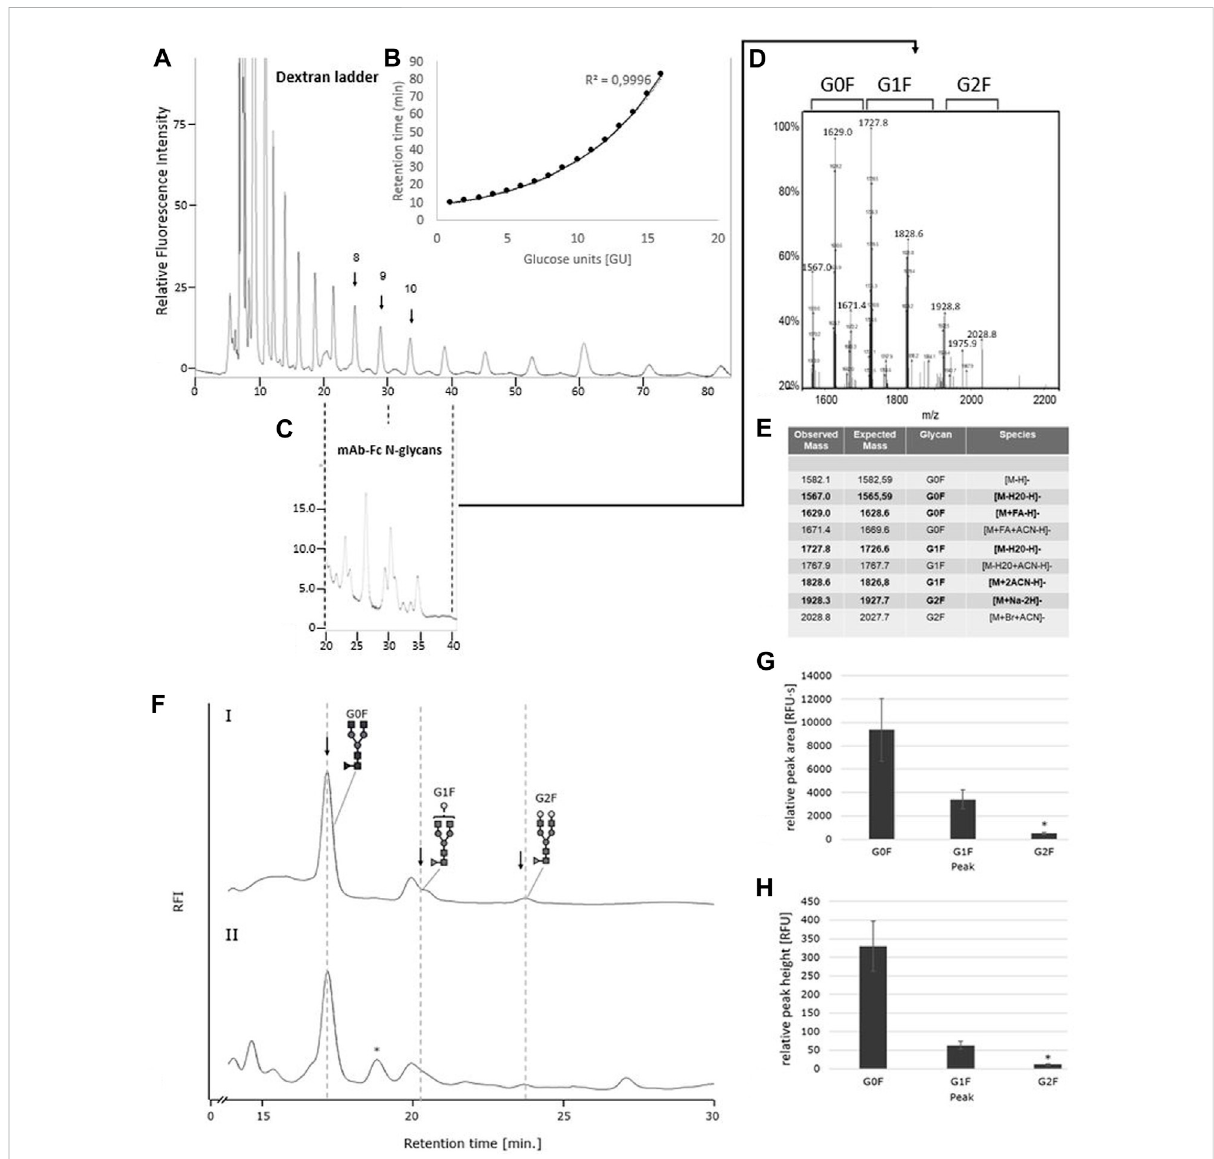
FIGURE 7 The IgG1-mAb-Fc N-glycan pro fi les released by PNGase F and Oxone ® /Bromide are identical by HILIC-FLD analysis. (A) HILIC-FLD Separation of2-AAlabelleddextranstandardata fl owrateof0.5 mlwithindicationofindividualretentiontimesforhexoseunitpeaks(GUunits). (B) PlotofHILIC retention times versus size of hexose units. Note the direct correlation between HILIC retention time and size of the linear oligosaccharides. (C) HILIC-FLD chromatogram of 2-AA glycans derived from IgG1-Fc. Peaks for G0F, G1F and G2F elute in the vicinity of the respective GU unit standardpeak. (D) ESI-MSspectrumforthecollectedHILICpeaksfortheIgG1-Fcglycans. (E) ESI-MSpeakassignmentfortheESI-MSpeaksshownin panel (D,F) . HILIC-FLD peak pro fi les for 2-AA-labeled N-glycans released by PNGase F (chromatogram FI) or Oxone ® /Bromide (chromatogram FII). Column: OTU Amino 250 × 4.6 mm, isocratic solvent: 60 % ACN / 10 mM ammonium formate (pH 4.4), fl ow rate: 0.5 ml/min (Panel A,C ). 1 ml/min (Panel F ), column temperature: 25 ° C, fl uorescence detection: λ ex = 360 nm, λ em = 420 nm; GAIN 100. Bottom panels: Mean values and standard deviation for peak area (G) in relative fl uorescence units x second [RFU · s] and peak height (H) in relative fl uorescence units [RFU] for the individual peaks ( n = 3). * n =